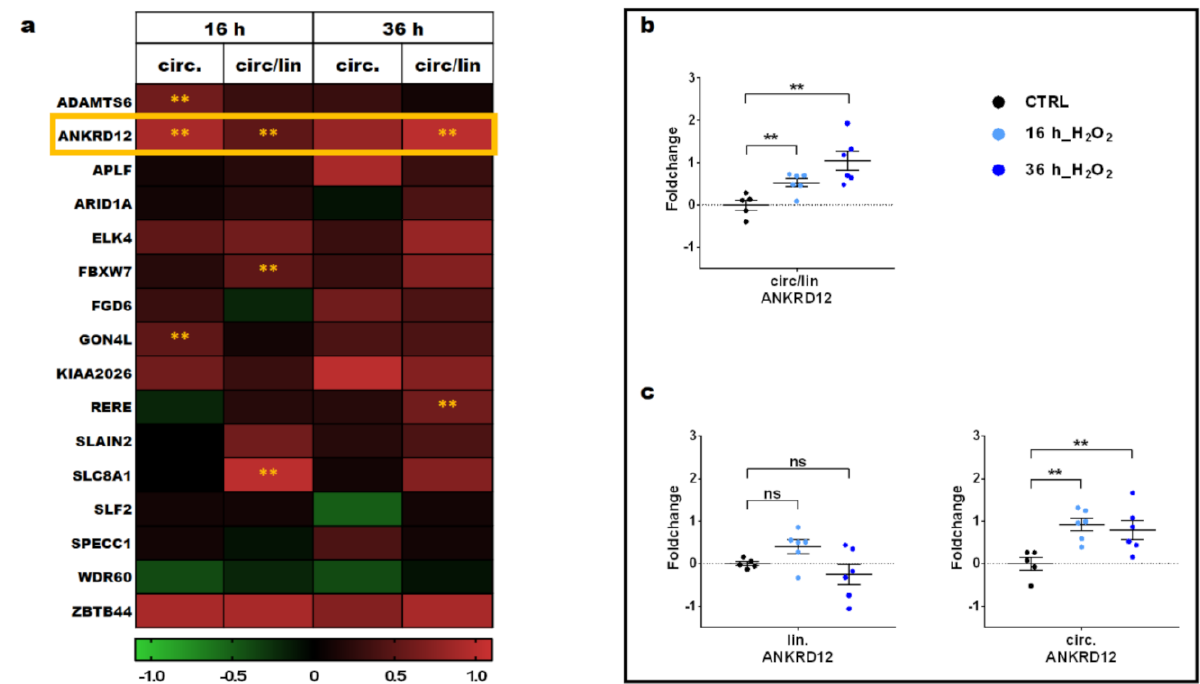
Figure 2. circANKRD12 is induced by H 2 O 2 treatment of HUVEC. HUVEC were treated with 200 µ M H 2 O 2 for 16 and 36 h or with solvent alone for 16 h as control. Expression levels of linear and circular transcripts were measured by qPCR. All fold changes are in log2 scale ( − ∆∆ CT). Among all RNAs tested, only circANKRD12 displayed a sustained modulation. ( a ) Heatmap of technically conclusive candidates, showing differences in expression of H 2 O 2 -treated samples compared to controls as fold changes. The significance threshold was set at p < 0.01 (** p < 0.01; n = 3). ( b ) Scatterplot of circular- to-linear ratio (circ/lin) of ANKRD12 in HUVEC exposed to H 2 O 2 compared to control (CTRL). ( c ) Scatterplots of the expression levels of circular (circ.) and linear (lin.) ANKRD12 transcripts in HUVEC exposed to oxidative stress compared to CTRL. For both panel ( b , c ), individual values are indicated by dots, while mean and SEM are indicated by horizontal lines ( n = 6; ** p < 0.01; ns: not